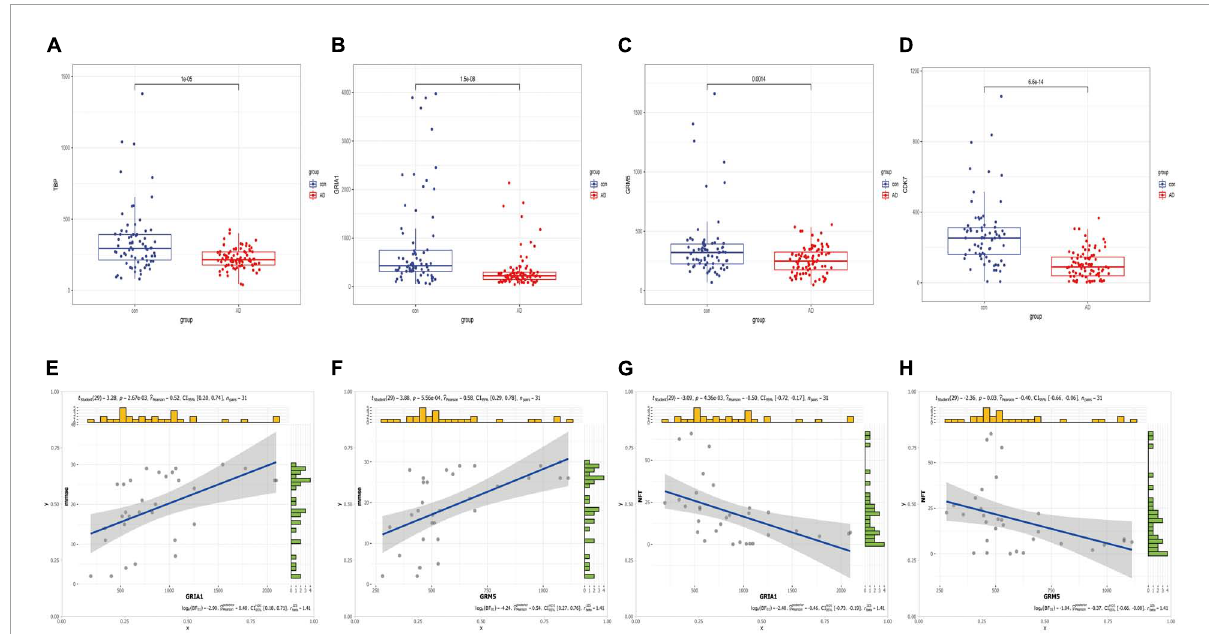
FIGURE10 Boxplots of hub mRNA and correlation with clinical information. (A–D) Based on the difference boxplot of TBP, GRIA1, GRM5, and CDK7 between the normal group and AD group (GSE5281 data set). (E–H) The correlation between GRIA1, GRM5, and clinical information MMSE, NFT,